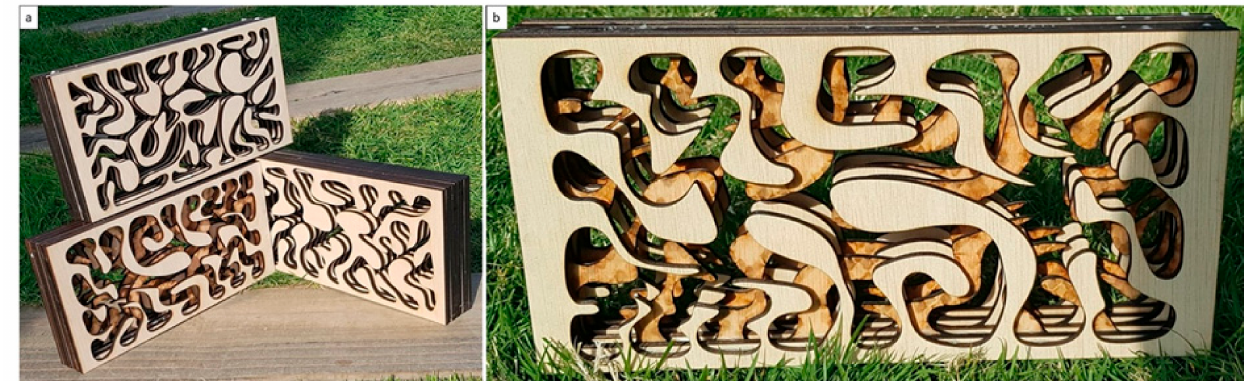
Figure 9. Alberto T. Est é vez (Yomna K. Abdallah, computational designer), Biodigital Barcelona Bricks (laser-cut wood), GENARQ/iBAG, UIC Barcelona. Various design possibilities that emerged from varying the stacking or contouring orientation of each biodigital brick design iteration.( a ) The achievement of these possibilities by varying the distance between each profile and then allowing the integration of soil or other biomaterials so as to be able to grow plants for vertical farms or gardens by varying the orientation of each profile (from the front, back, right, and left) and by applying permutations through combining the profiles from the three different design iterations together in one contoured brick design, as shown in ( b ). Photos by the